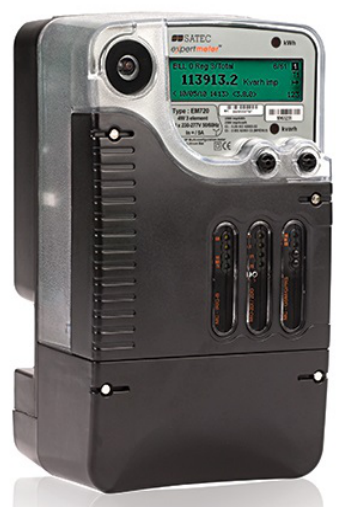
Figure 5. SATEC EM720 smart power meter.